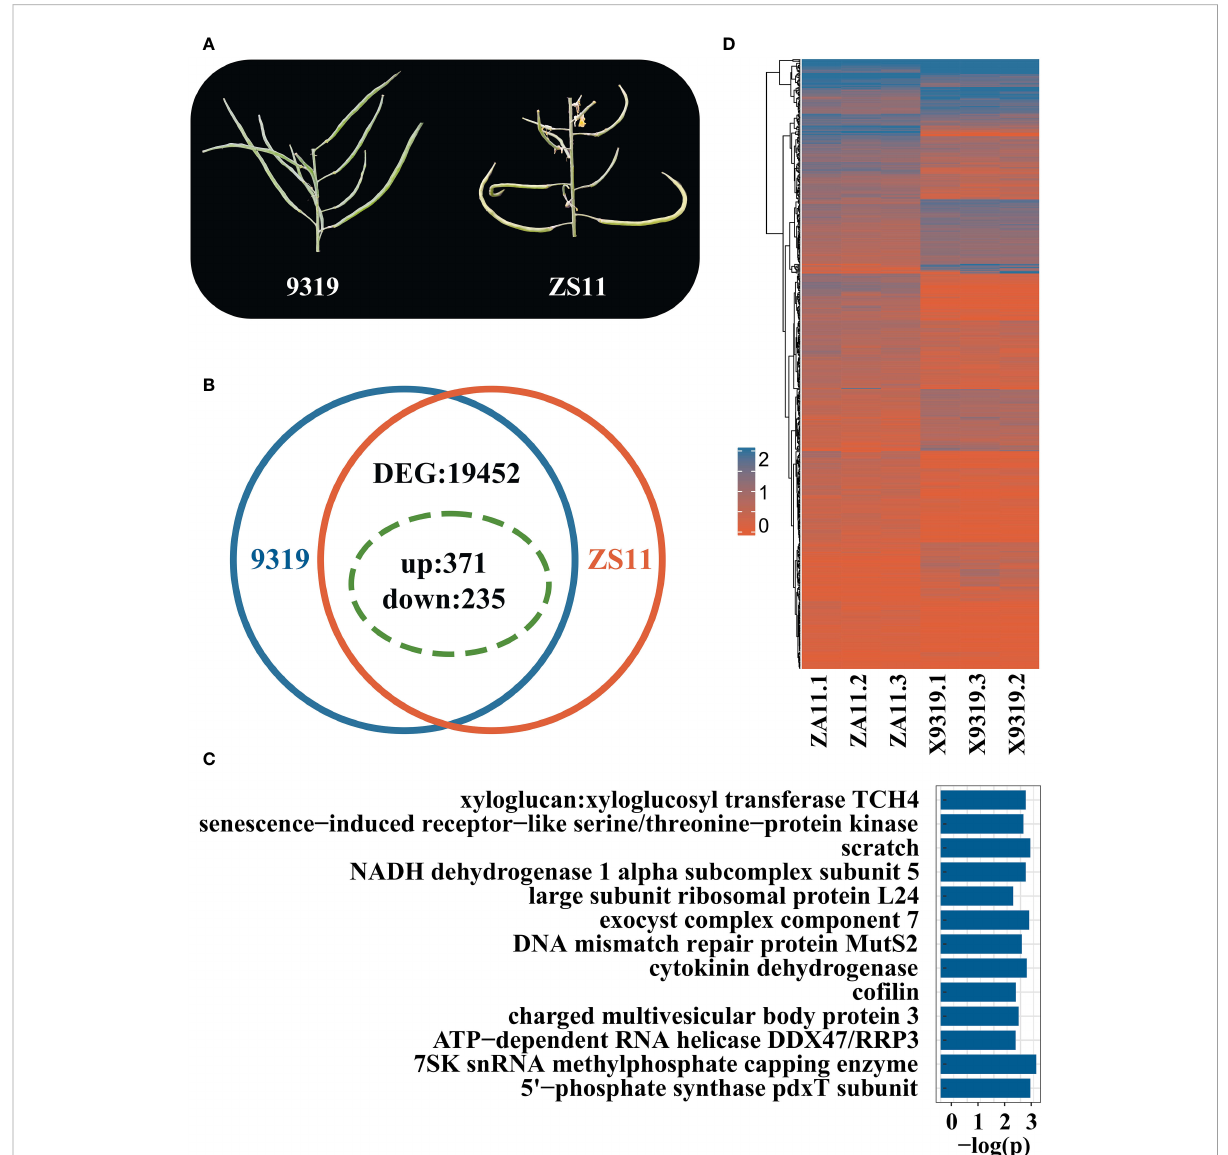
FIGURE 6 RNA-seq analysis of rapeseed lines with contrasting pod orientation phenotypes. (A) Phenotypic difference of pod orientation between 9319 line (Angle of the pedicle to raceme (inclined type, 59°, the angle of the pod to pedicel is 170°) and ZS11 line (Angle of pedicel to raceme, fl at type, 90°; Angle of the pod to pedicel:170°); (B) Statistics summary of differentially expressed genes (DEGs) between 9319 and ZS11. The green dotted circle indicates the DEGs in QTL; (C) Enriched KEGG pathways of candidate DEG between 9319 and ZS11; (D) Heat map of candidate genes of DEG expression, the expression levels were transformed by log 10 (x+1), 0 represents that the gene was not expressed, and 2 represents that the expression level was